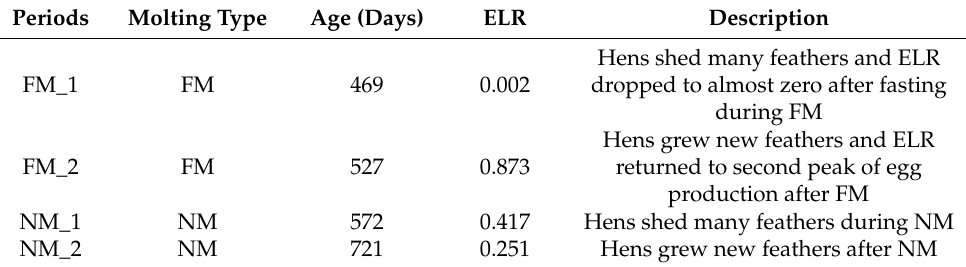
Table 1. Chicken information for two periods of FM and